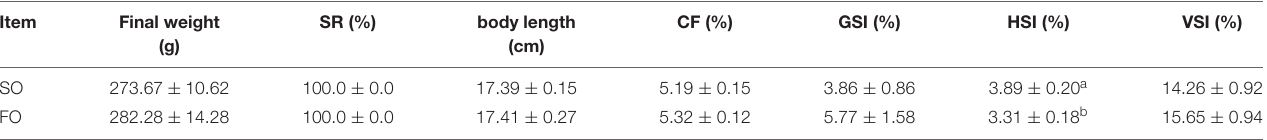
TABLE 4 | Growth performance of female spotted scat fed with different oil sources.